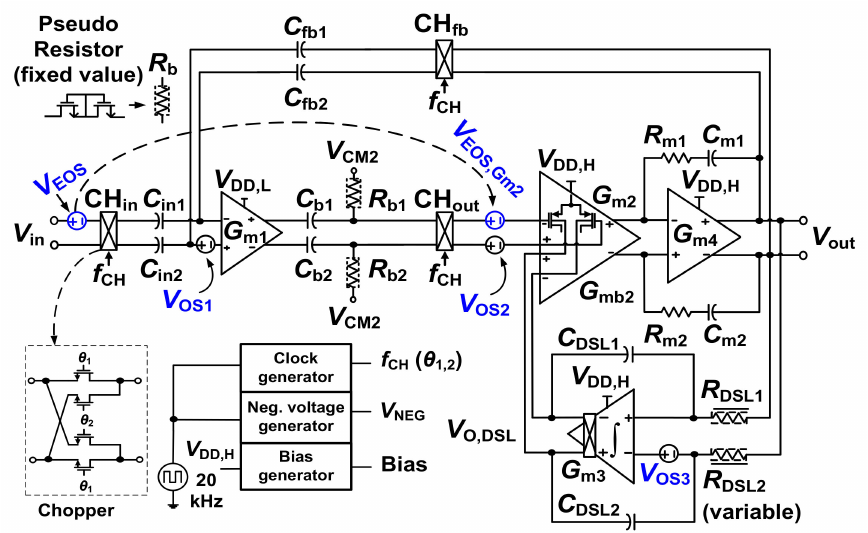
Figure 1. Schematic of the proposed capacitively-coupled chopper instrumentation amplifier (CCIA) using body-controlled DC servo loop (DSL). C in1,2 = 4 pF, C fb1,2 = 40 fF, C b1,2 = 3 pF, C m1,2 = 4 pF, R m1,2 = 4 M Ω , and C = 5 DSL1,2